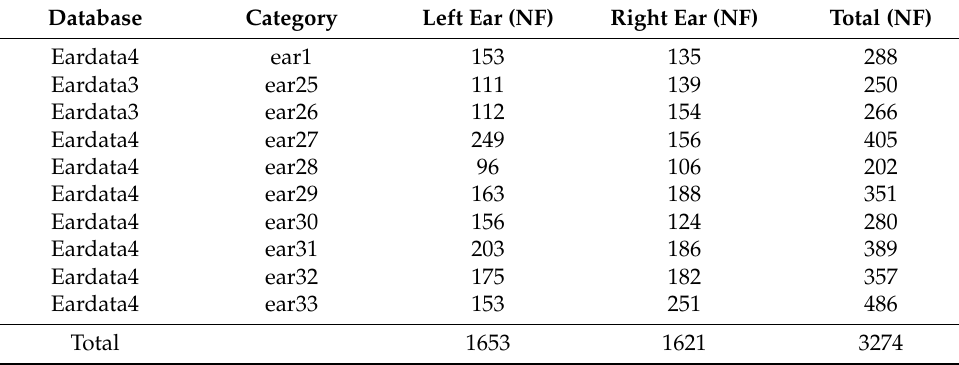
Table 10. Training sample